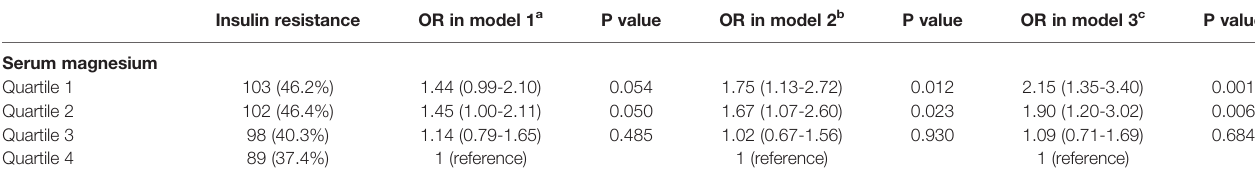
TABLE 4 | Association between insulin resistance status and serum magnesium according to quartiles by logistic